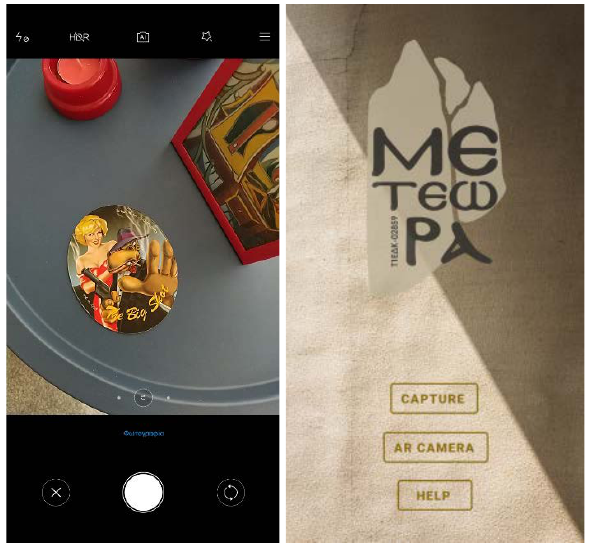
Figure 1 . User interface of the application. Left: Home Screen; Right: Camera user interface for pattern image